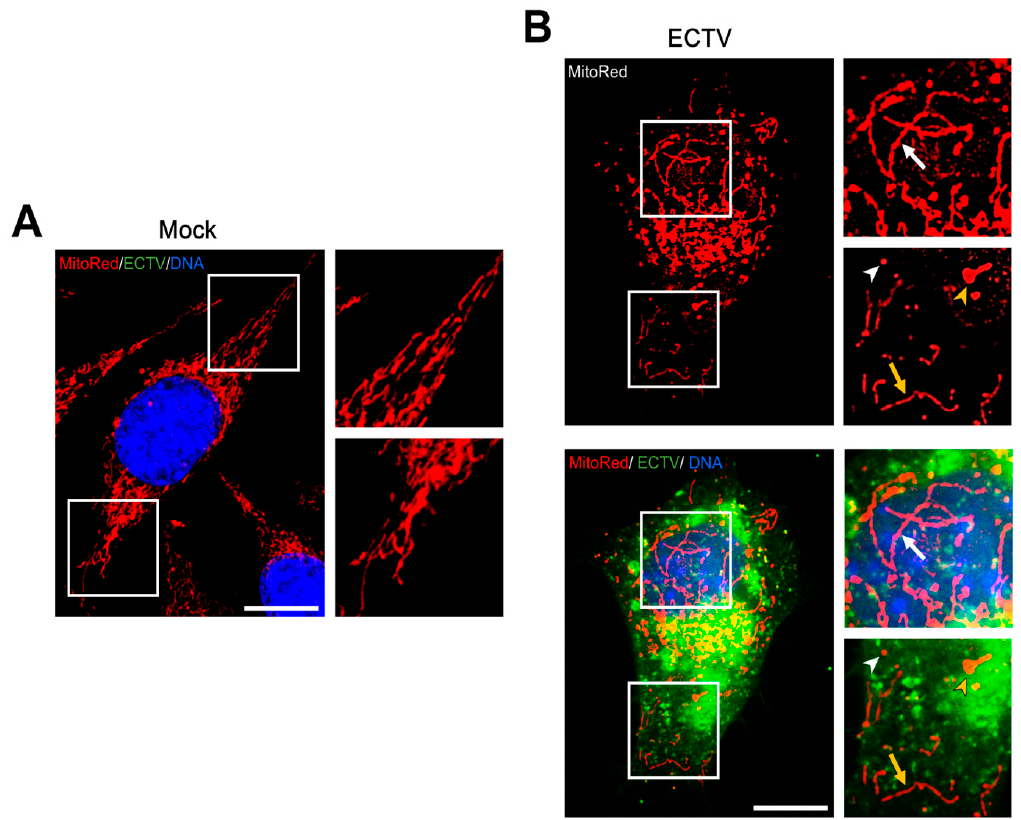
Figure 5. Mitochondrial network morphology in L929 cells at 12 hpi with ECTV. Interconnected mitochondrial network in mock-infected cells ( A ). Disorganized and fragmented mitochondrial network in ECTV-infected cells ( B ). White arrows indicate loose mitochondrial network (“loose net”). White arrowheads indicate small, punctate mitochondria. Yellow arrows indicate short, non-connected mitochondrial tubules. Yellow arrowheads indicate donut-like mitochondria. Scale bar: 10 µm.